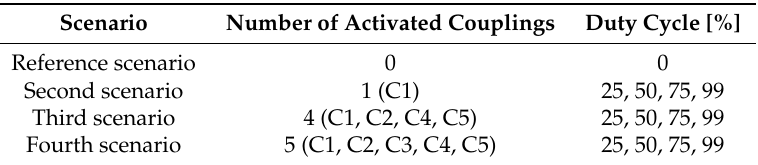
Table 2. The measurement